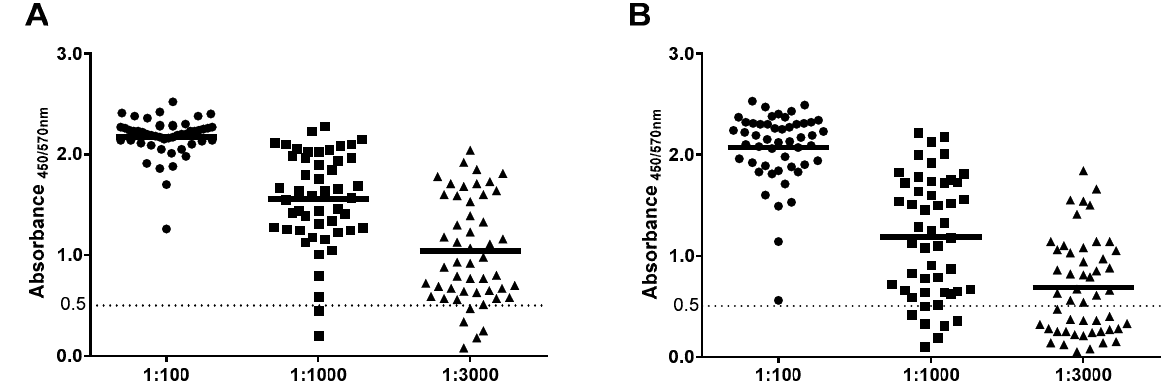
Figure 3. ( A ) S1 and ( B ) RBD test results of the 50 serum samples. Three dilutions (1:100, 1:1000, and 1:3000) per serum sample were assayed. Each data point is the average of duplicates.